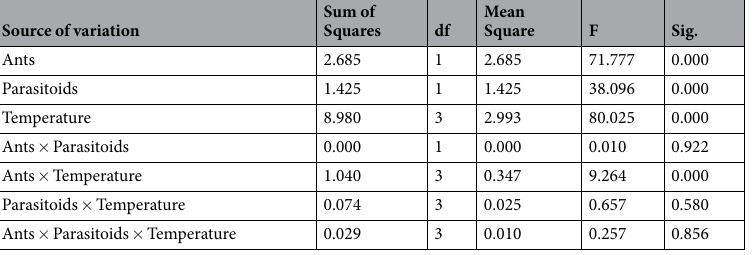
Table 1. Analysis of variance of the mealybug colony growth rate with ant tending, parasitoid, and